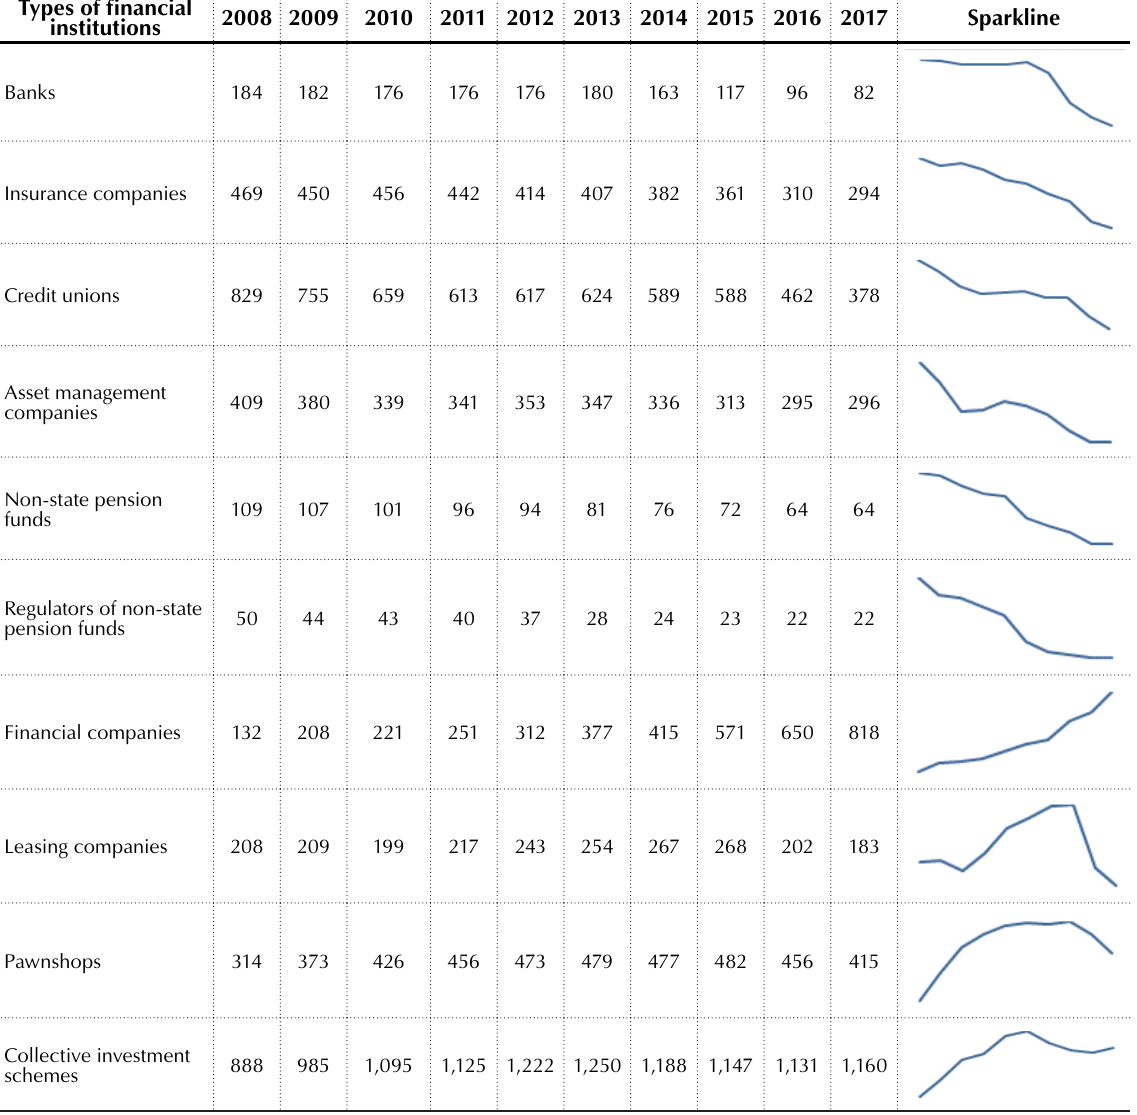
Table 1. Number of financial intermediaries in Ukraine in 2008–2017 (as at the end of the year) Source: Compiled by authors according to the data from the National Bank of Ukraine, the National Commission for State Regulation of Financial Services Markets, and the Ukrainian Association of Investment Business. Types of financial